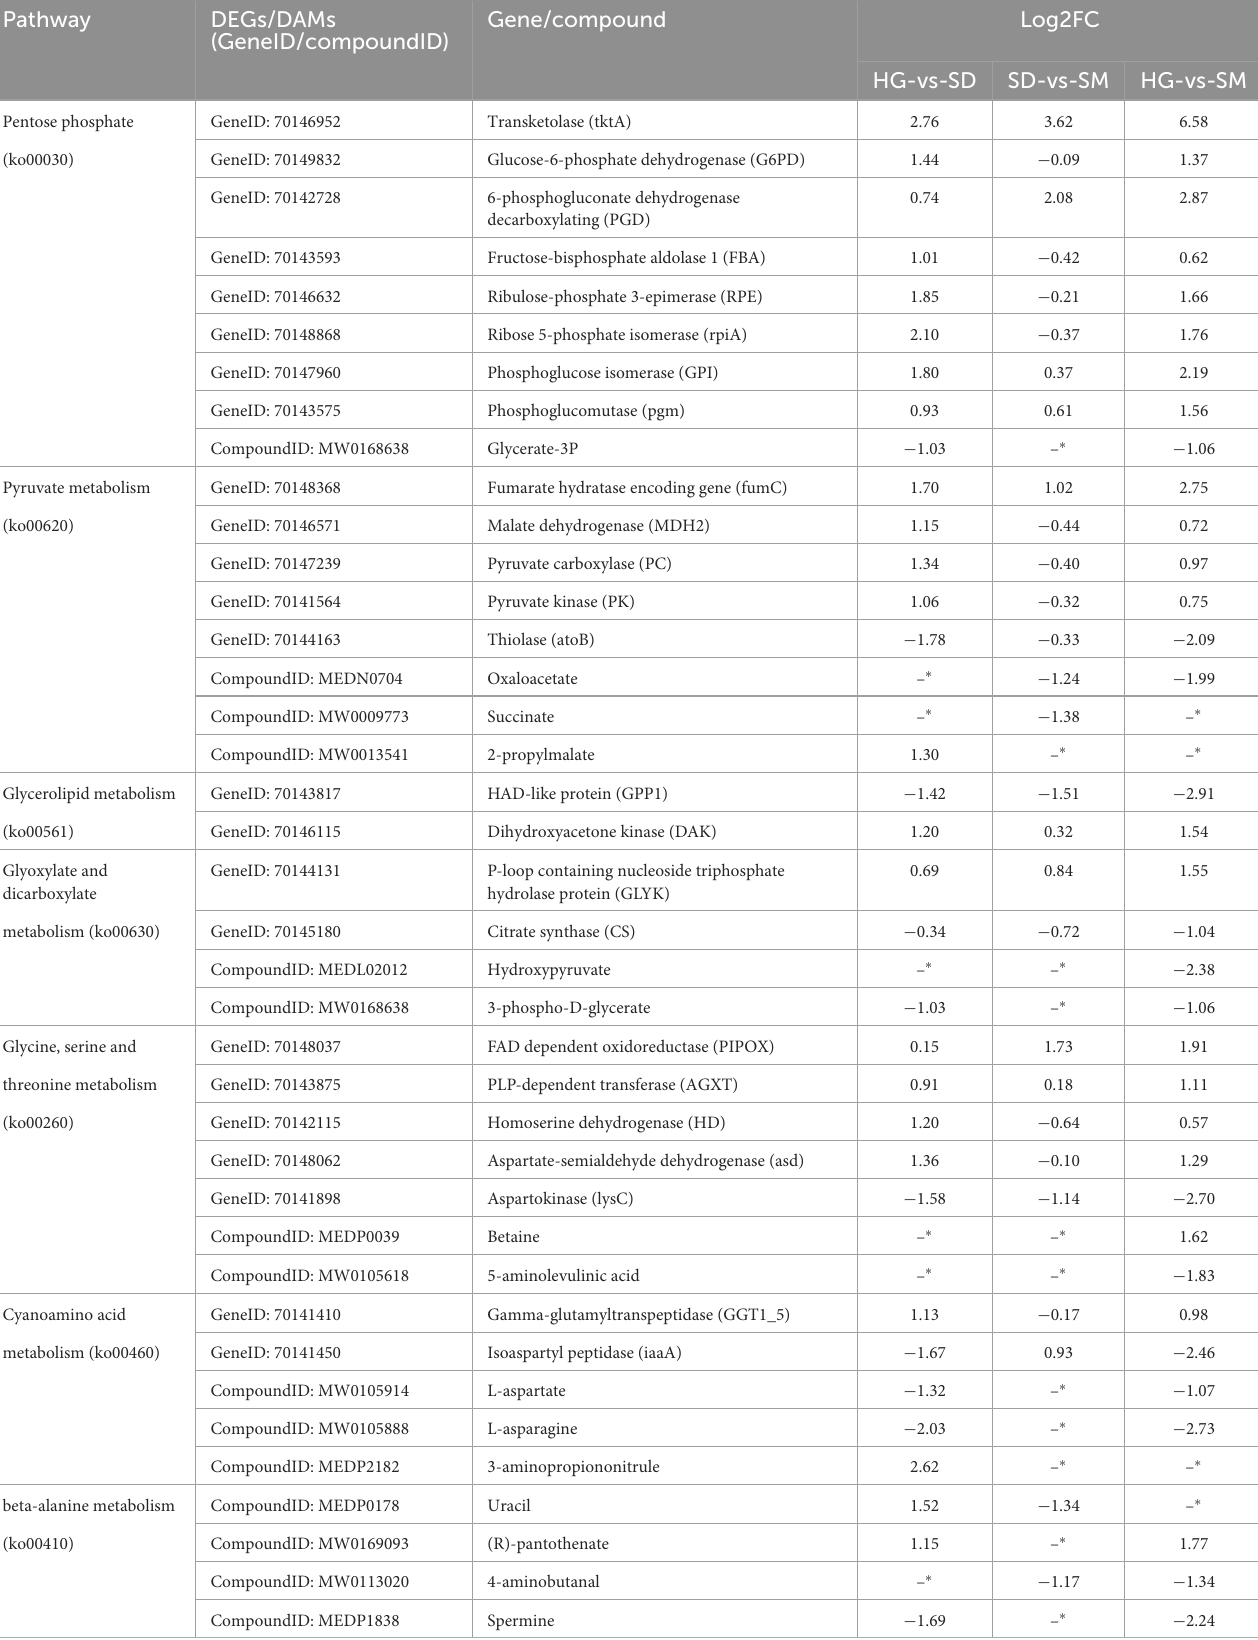
TABLE 2 DEGs and DAMs participating in the seven pathways involved in mycelium growth.